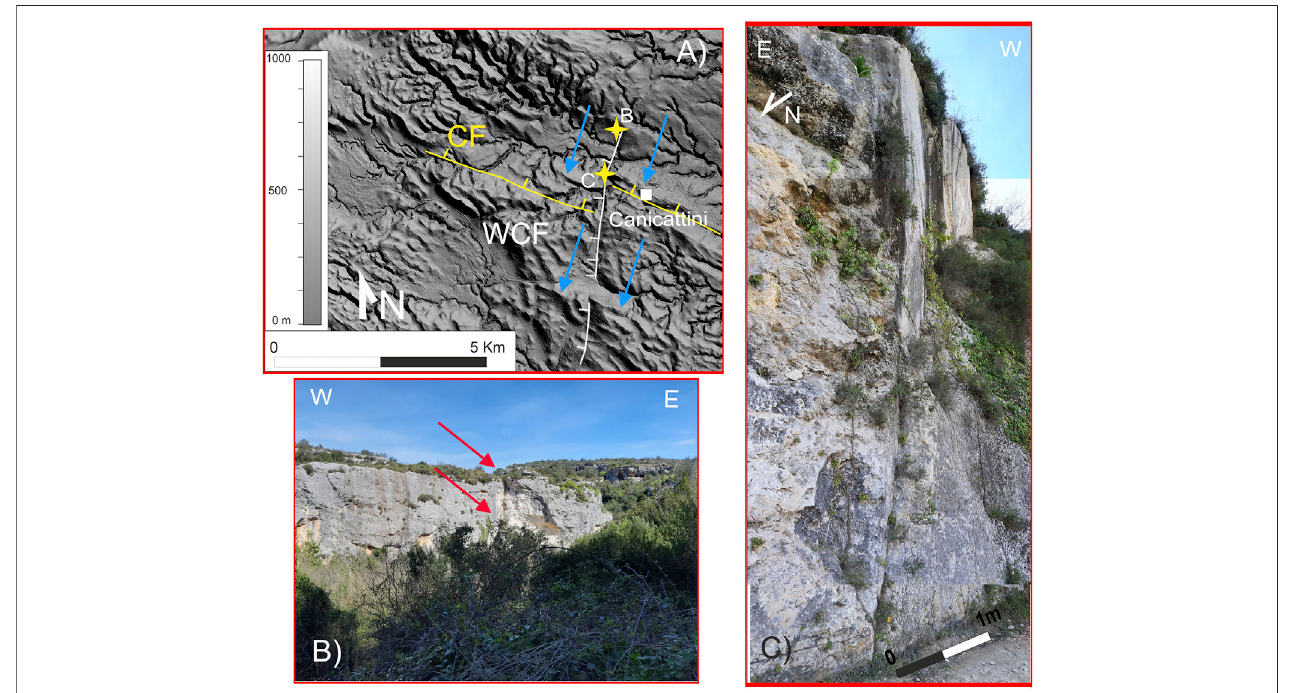
FIGURE8|(A) DEMshowingWCFdislocatingtworidges( fi gurelocationin Figure6B ). (B,C) photosofWCFnorthwestandwestofCanicattinitown,respectively.